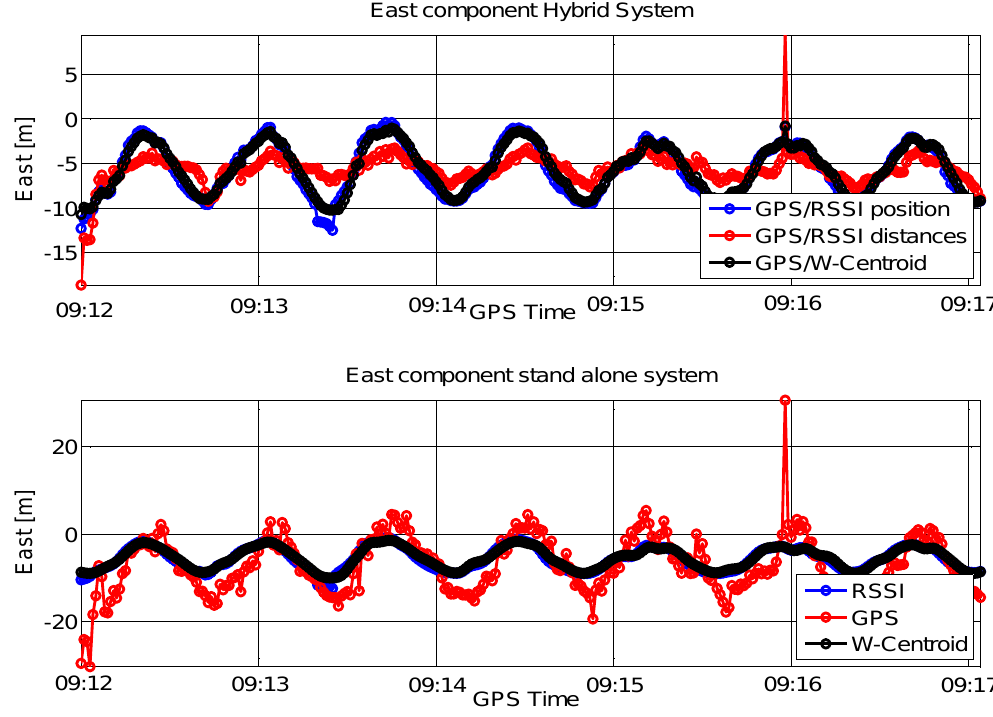
Figure 10. East component estimated for the repeatability test performed in a large meeting room.